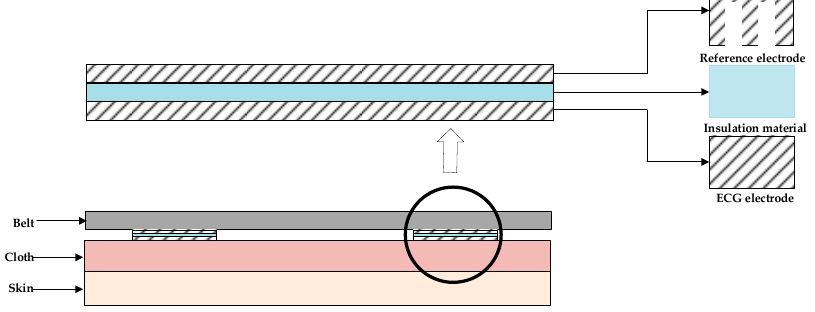
Figure 2. Schematic diagram of the wearable electrode structure.